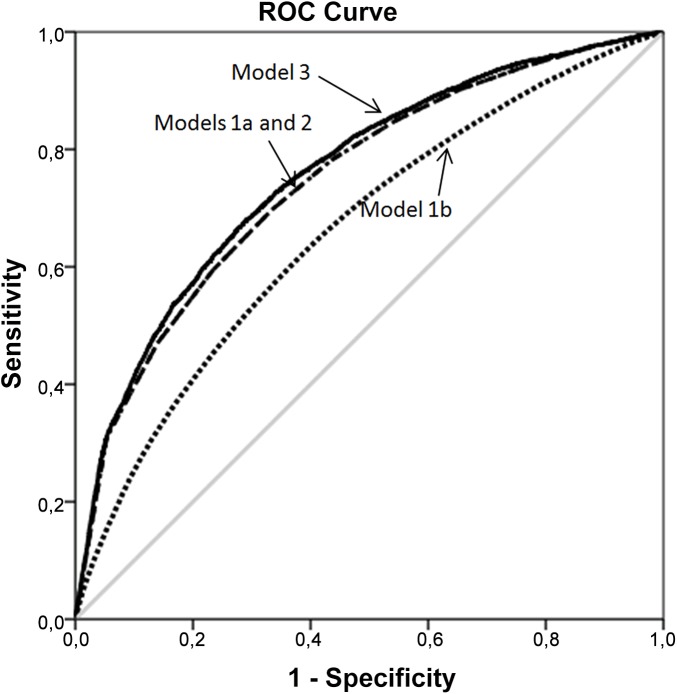
ROC-curves for Models 1a, 1b, 2 and 3.